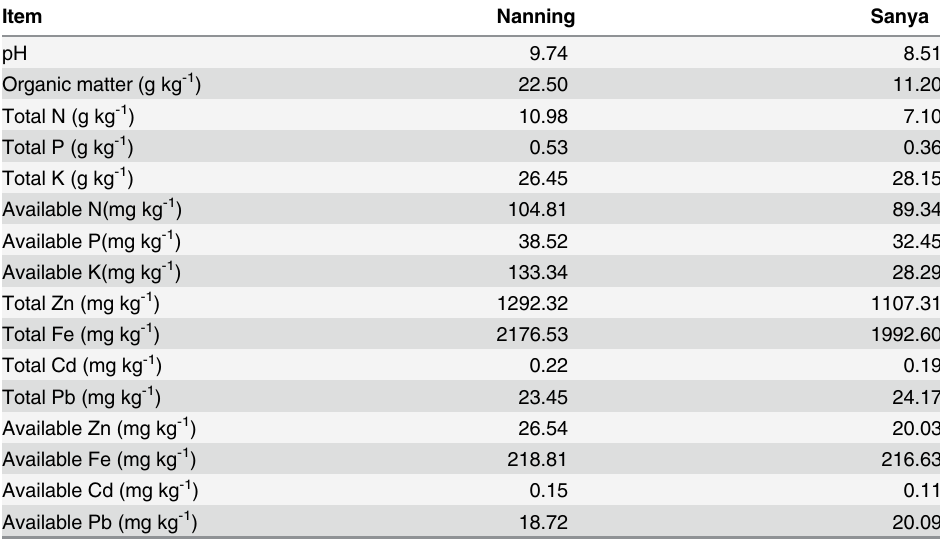
Table 1. Physical and chemical characteristics of the soil in the experimental